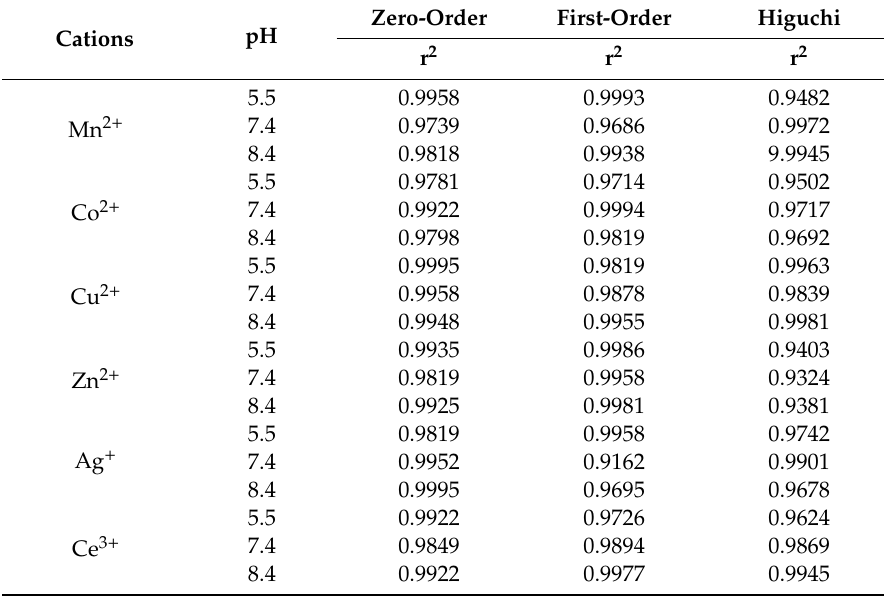
Table 2. Correlation coe ffi cients, r2, of fitting cation release according to kinetic models.